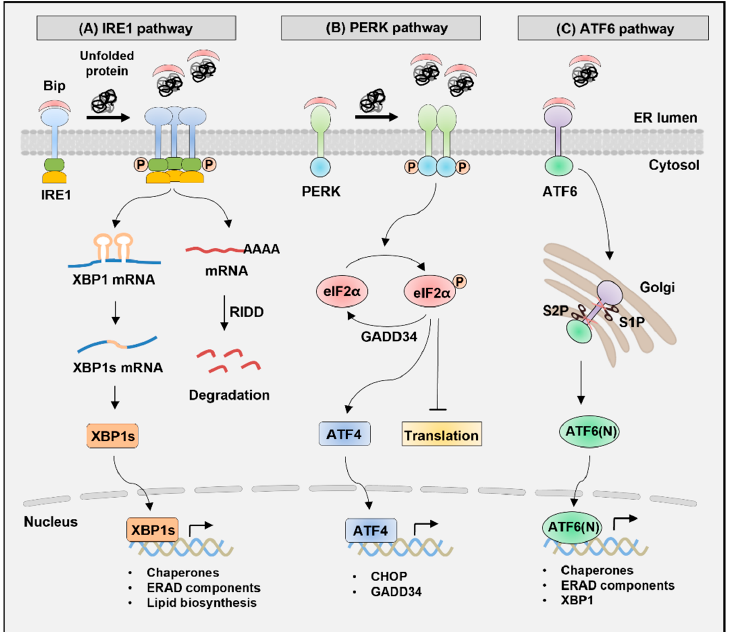
Figure 1. Signaling pathways of UPR. Signaling pathways of UPR are mediated by three ER-resident proteins: IRE1, PERK, and ATF6. In the absence of ER stress, BiP binds to the ER luminal domain of the sensor proteins and inhibits their activation. However, ER stress induces the dissociation of BiP from the sensors, which activates UPR transducers. ( A ) IRE1 pathway: IRE1 has serine/threonine kinase and RNase domains in the cytoplasmic region. Upon ER stress, IRE1 is activated via oligomer- ization and autophosphorylation, leading to increased RNase activity. Activated IRE1 recognizes the stem-loop structure of Xbp1 mRNA and induces unconventional splicing by cleaving 26 intronic nucleotides. The spliced Xbp1 mRNA is translated by frameshift into an active transcription factor, XBP1s. Then, XBP1s upregulates the expression of UPR target genes, including ER chaperones, ERAD components, and lipid biosynthetic enzymes. Furthermore, IRE1 recognizes various mRNAs besides Xbp1 mRNA as substrates under ER stress and induces the degradation of these mRNAs, a process known as regulated IRE-dependent decay (RIDD). RIDD is a mechanism that resolves ER stress by degrading mRNAs encoding ER-targeted proteins, thereby reducing protein loads into ER. ( B ) PERK pathway: PERK has a serine/threonine kinase domain in its cytoplasmic region. ER stress induces PERK activation via oligomerization and autophosphorylation in the kinase domain. Activated PERK then phosphorylates the serine 51 residue of eIF2 α , resulting in alleviation of ER stress by attenuating translation. By contrast, phosphorylated eIF2 α selectively promotes the translation of ATF4, which activates the transcription of CHOP and GADD34. After ER stress resolution, GADD34 interacts with PP1 to induce eIF2 α dephosphorylation, restoring protein translation. However, if ER stress is not resolved, CHOP induces apoptosis. ( C ) ATF6 pathway: ATF6 has an N-terminal b-ZIP domain in the cytoplasmic region. ER stress induces ATF6 translocation from ER to the Golgi apparatus, where ATF6 is cleaved by S1P and S2P. This proteolytic cleavage produces the N-terminal region of ATF6, referred to as ATF6(N). ATF6(N) functions as an active transcription factor and upregulates target genes encoding ER chaperones, ERAD components, and XBP1. IRE1, inositol-requiring enzyme 1; PERK, protein kinase R-like ER kinase; ATF6, activating transcription factor 6; RNase, endoribonucle- ase; XBP1, X-box binding protein 1; ERAD, ER-associated protein degradation; eIF2 α , eukaryotic translation initiation factor 2 α ; ATF4, activating transcription factor 4; CHOP, C/EBP homologous protein; GADD34, growth arrest and DNA damage-inducible protein 34; PP1, protein phosphatase 1; S1P, site-1